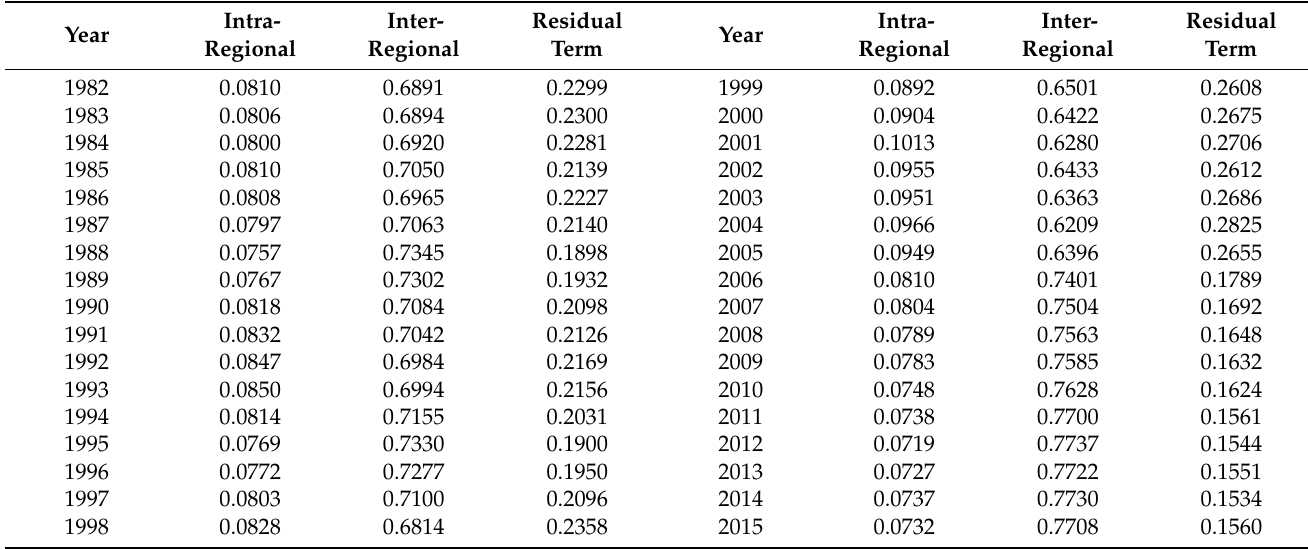
Table A2. The contribution rate of intra-regional, inter-regional and residual term.